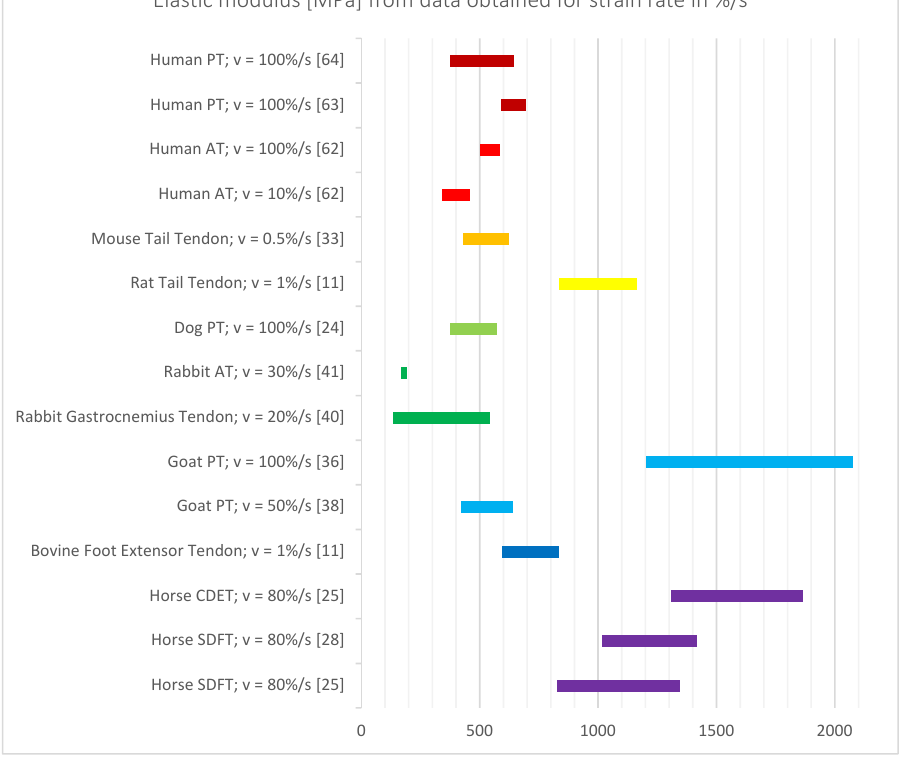
Figure 5. Young’s modulus for the considered animal species (%/s).